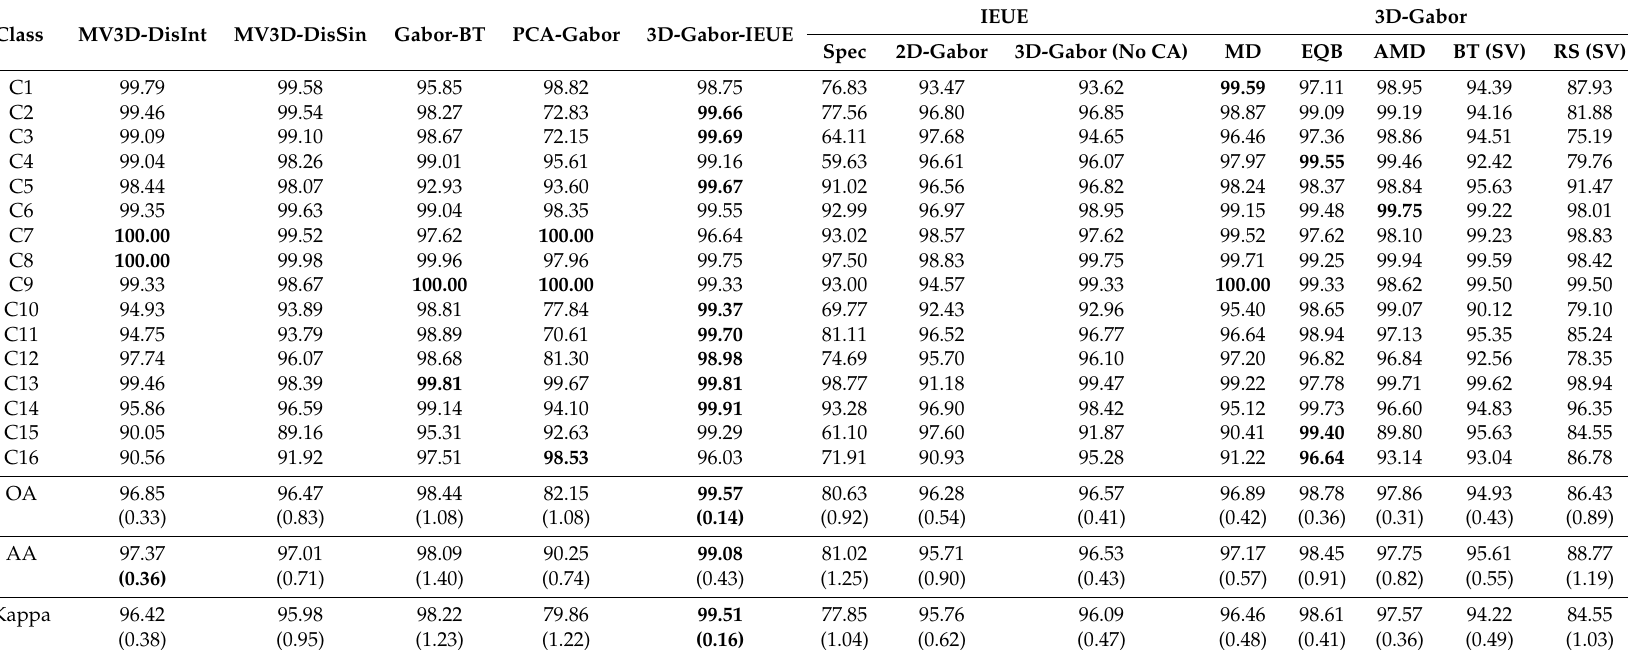
Table 3. Classification accuracies [ % ] of different view generation and sampling selection methods for the Indian Pines dataset, using 80 initial training samples (5 per class) and 240 selected samples. For PCA-Gabor, 320 samples (20 per class) are used for training. The numbers in parenthesis are standard deviations. Bold values indicate the best result for a